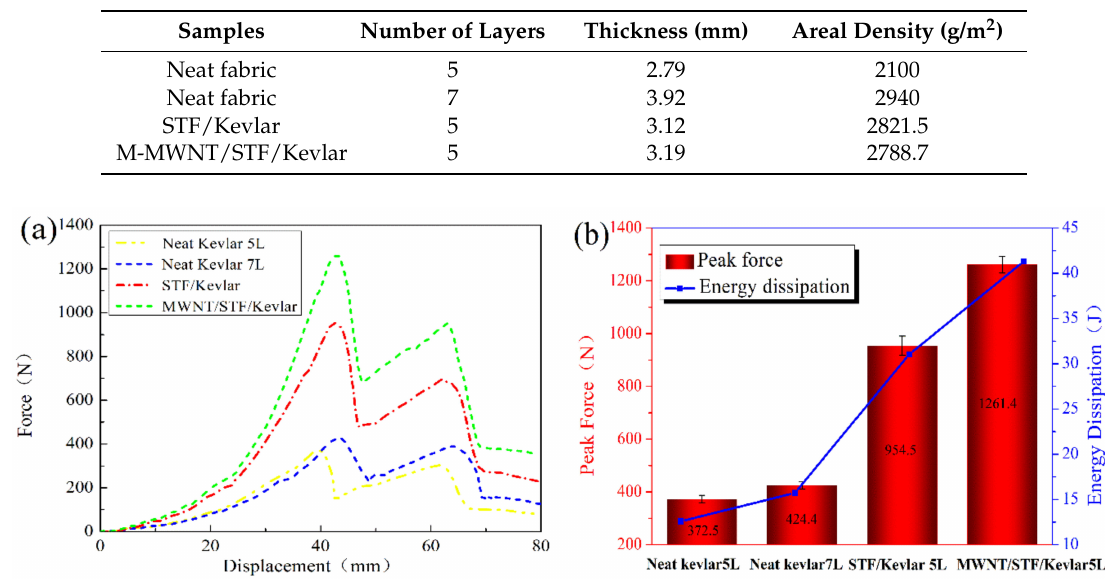
Figure 7. ( a ) Force-displacement curves for quasi-static loading of neat Kevlar fabrics, STF/Kevlar fabrics and M-MWNT/STF/Kevlar fabrics; ( b ) The energy dissipation during the impact process and the peak